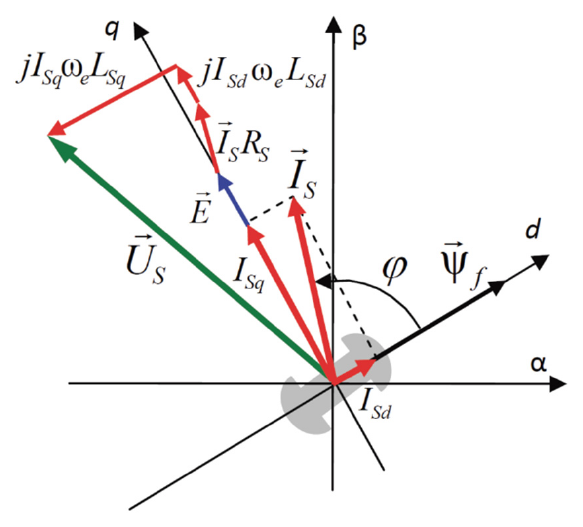
Figure 1. Vector diagram, which explains the processes occurring in a synchronous motor [20]. The rotor of the motor, being a permanent magnet, produces a flux capacitance ψ f , equal to the product of the rotor flux by the number of turns of the stator winding. The vector of this current-circuiting is directed along the rotor axis d from the positive pole to the negative pole and lags behind the stator current vector Is by some angle ϕ . The constant flux of the rotating rotor creates in stator windings the vector of electromagnetic field ( EMF ) E directed at a right angle to the flux and leading it by 90 degrees (the derivative of rotor current-current d ψ f / dt )